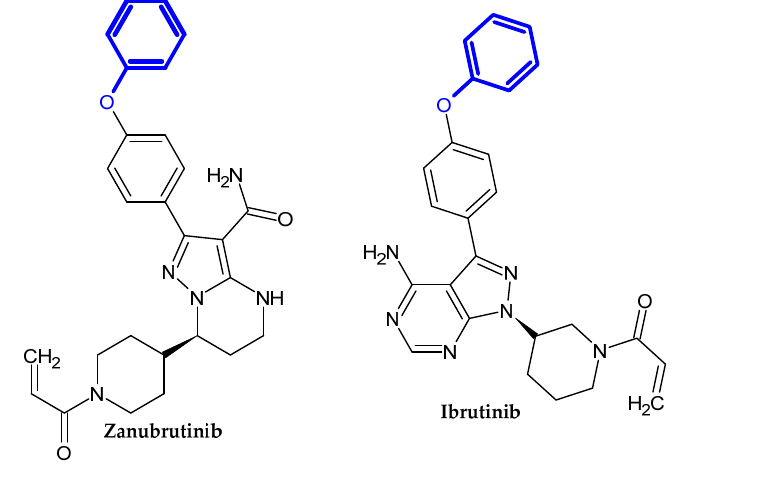
Figure 9. Anti-leukemia drugs.